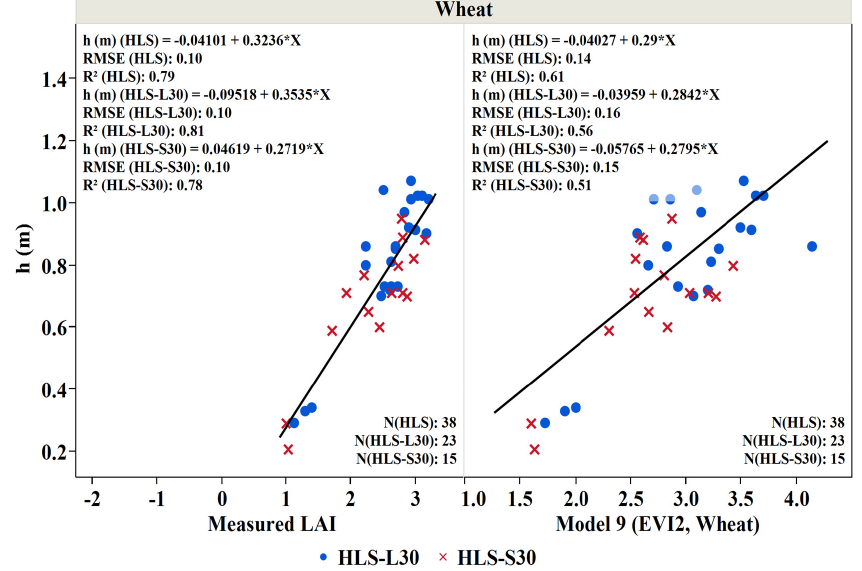
Figure 11 . Crop height (h (m)) as a function of measured LAI (m 2 /m 2 ) and LAI derived from Model 9 (EVI2, wheat) for wheat crop studied during the 2019 growing season. Blue points represent the measurements during Landsat overpass and the red crosses represent the measurements during Sentinel 2 overpass.